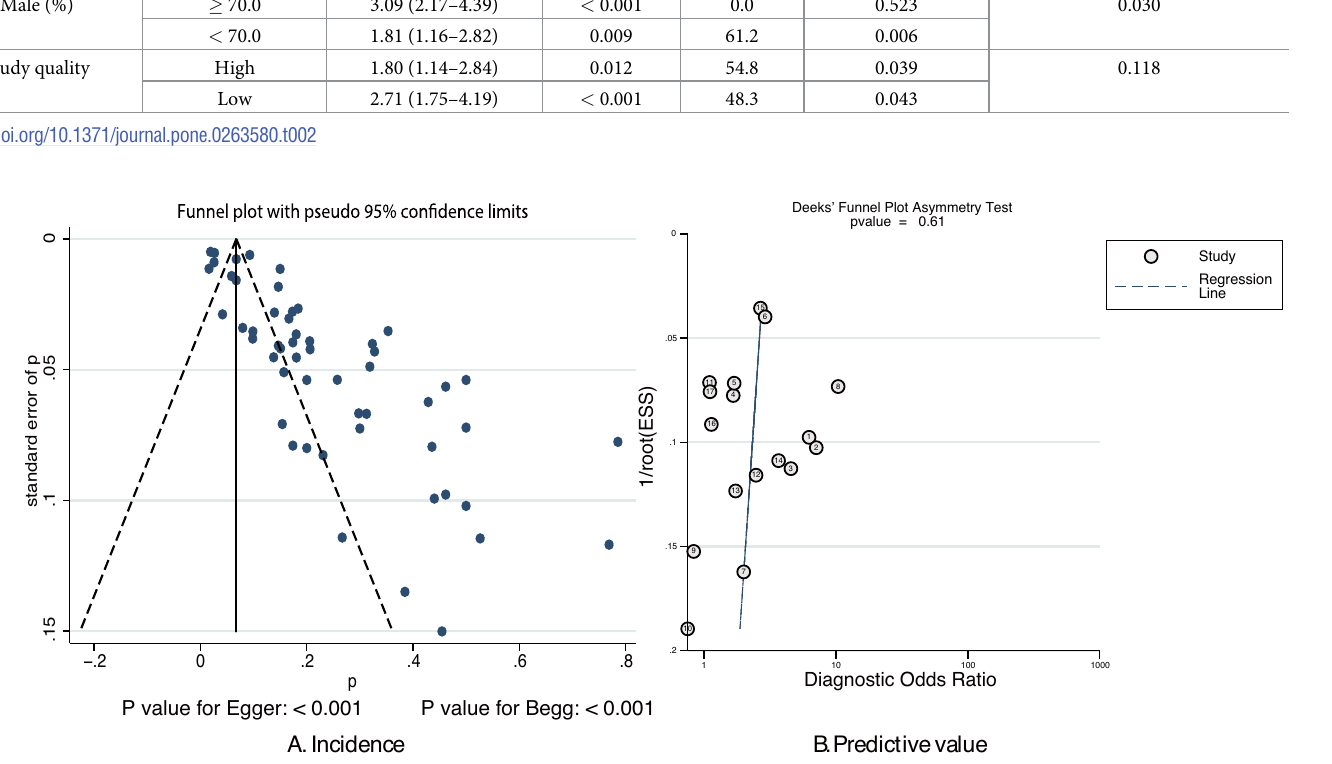
Fig 7. Funnel plot for the incidence of pulmonary embolism (A) and the predictive value of pulmonary embolism for ICU admission (B).